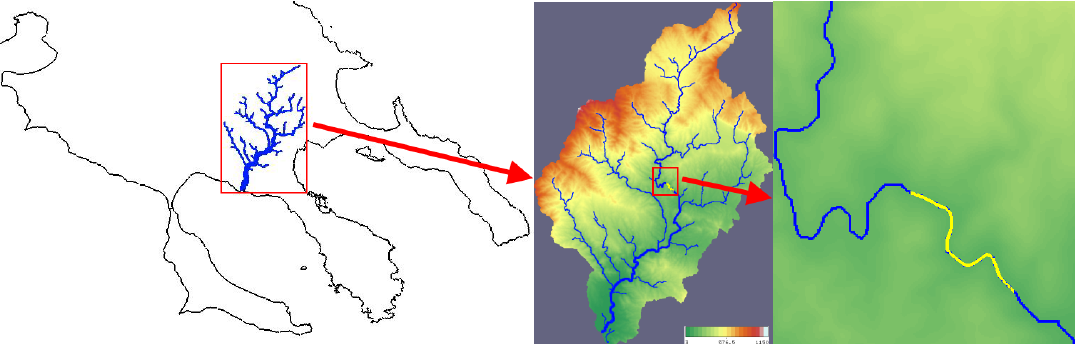
Figure 33. The study area map.